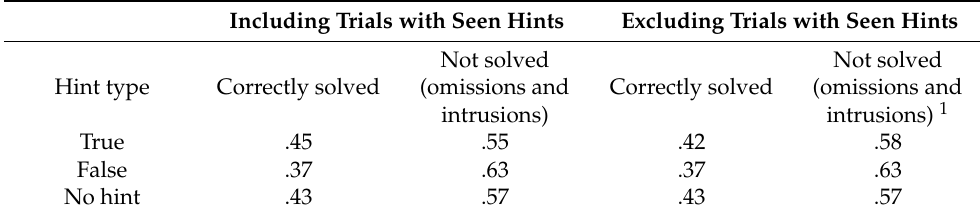
Table 1. Share of correct solutions across different hint types. Including Trials with Seen Hints Excluding Trials with Seen